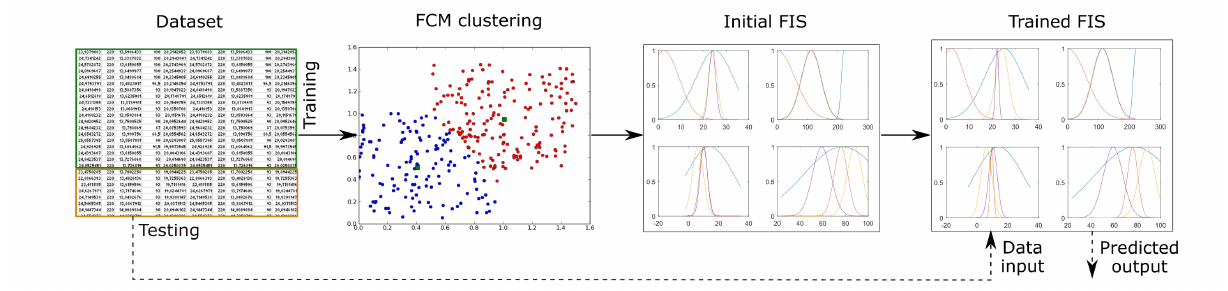
Figure 4. Structure of used ANFIS modelling